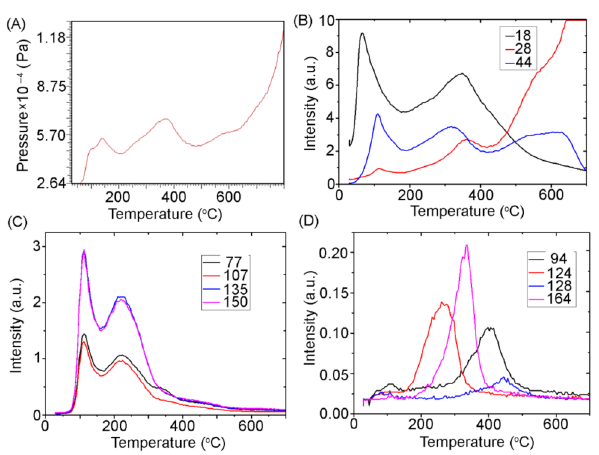
Figure 12. Thermal decomposition of FA/CeO2 (0.6 mmol/g); vapor pressure measured as a function of temperature for the FA/CeO 2 sample ( A ); TPD curves for ions with m / z 18, 24, and 44 ( B ), for ions with m / z 77, 107, 135, and 150 ( C ) and for ions with m / z 94, 108, 124, 128, and 164 ( D